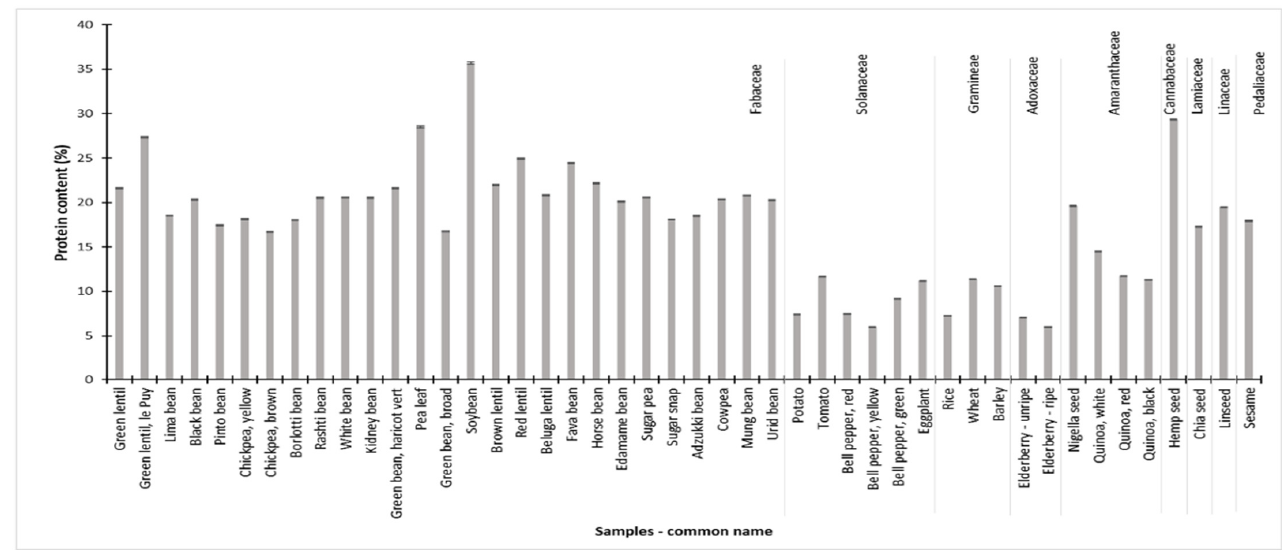
Figure 1. Protein content in unprocessed samples grouped in plant families. Protein content was determined through conversion of nitrogen contents (see section 2 for methodology). Each bar is the result of one determination ( n = 1) ± standard deviation (SD). SD was calculated from the positive control, which was analyzed eight times under reproducible conditions. For tabulated results and SD values see Table S1.